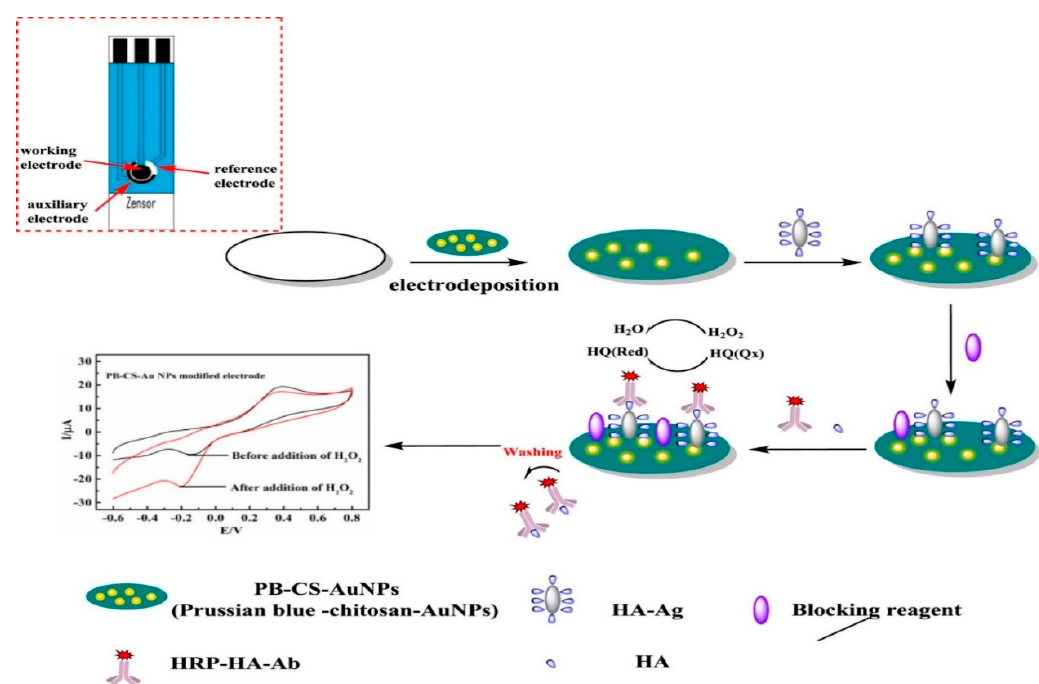
Figure 8. Fabrication of ECB strip for histamine (HA) detection. Portable immunosensor developed for the (point-of-care testing) POCT of HA with PB-CS-AuNPs [105]. Reprinted with permission from [105], Copyright © 2020 Elsevier Ltd. B.V.